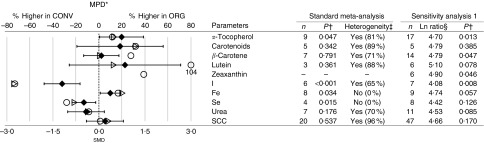
Results of the standard meta-analyses and sensitivity analysis 1 for antioxidants,
minerals, urea and somatic cell count (SCC) in cows’ milk. * Numerical values for
mean percentage difference (MPD) and 95 % CI are given in the online Supplementary
Table S9. † Significantly different between organic samples (ORG) and conventional
samples (CONV) (P<0·05). ‡ Heterogeneity and the I
2 statistic. § Ln ratio=Ln(ORG/CONV×100 %). || Calculated based on
published fatty acid composition data. , MPD calculated using
data included in sensitivity analysis 1; , MPD calculated using
data included in standard meta-analysis; , standardised mean
difference (smd) from the standard meta-analysis with 95 % CI represented
by horizontal bars; n, number of data points included in
meta-analyses.